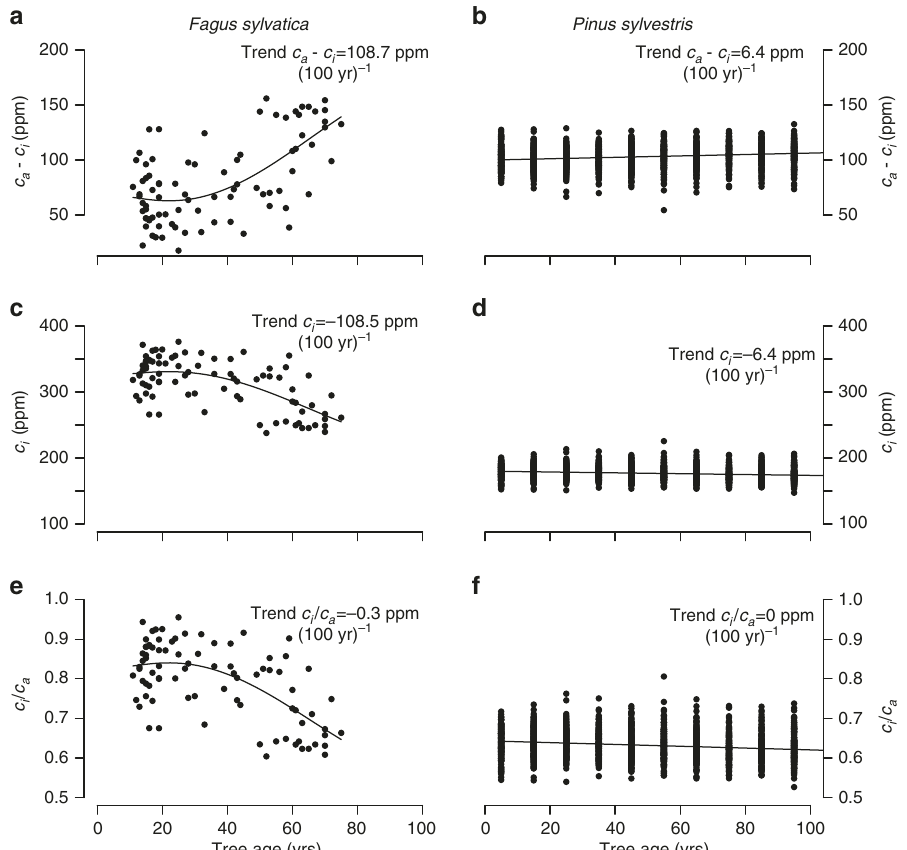
Fig. 4 Developmental trends in gas-exchange regulation diagnostics for Fagus and Pinus . a , b show air-to-leaf CO 2 difference ( c a − c i ), c , d show leaf internal CO 2 ( c i ) and e , f show the ratio of leaf-to-air CO 2 ( c i /c a ) plotted against tree age. These values are calculated from the average δ 13 C (see Methods section for formulas) of the fi ve outermost rings across a range of trees differing in tree age (for Fagus ) or from sub-fossil trees (for Pinus , Helama et al. 39 ). In both cases, age trends were controlled for changing CO 2 levels. a , c and e show results for Fagus and b , d and f for